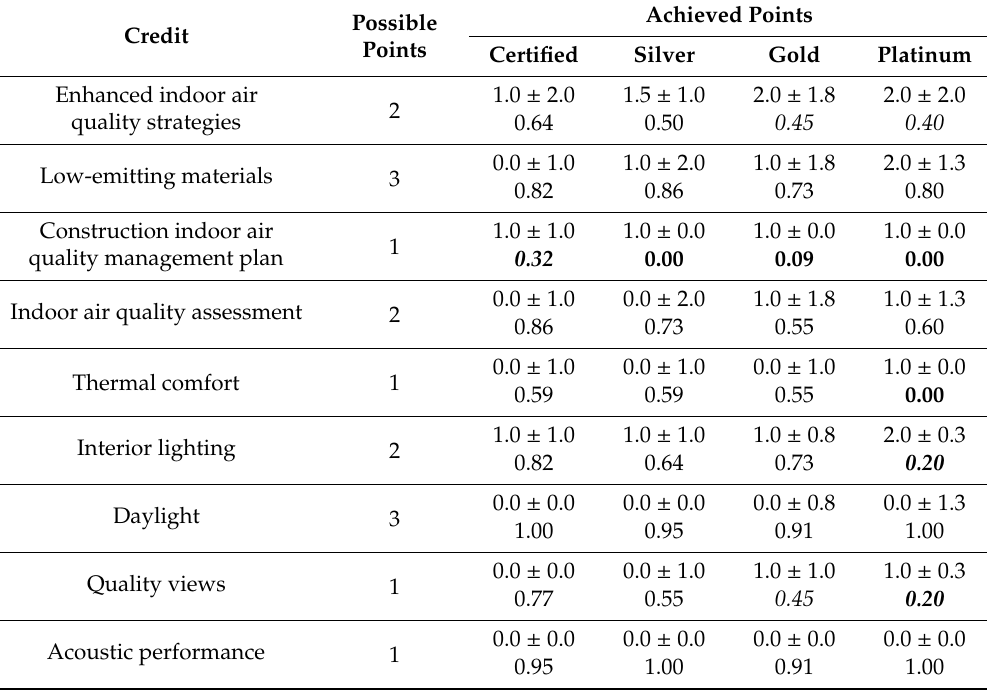
Table 7. Credit points achieved for Indoor Environmental Quality (EQ) category of